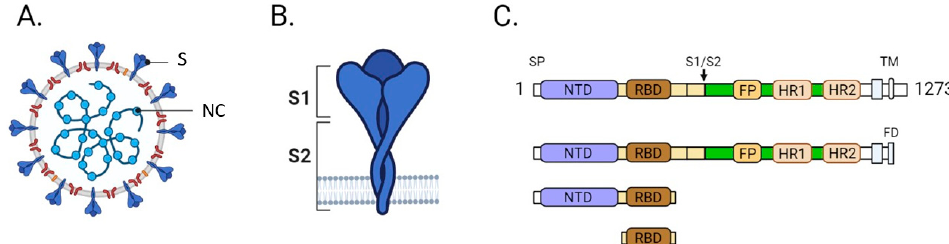
Figure 1. ( A ) Schematic drawing of the SARS-CoV-2 virus. Spike (S) and nucleocapsid (NC) proteins are highlighted. ( B ) Schematic drawing of the trimeric S-protein. ( C ) The domain structure of the S-protein is shown, and the three regions that were tested are depicted. All three versions contain the receptor binding domain (RBD). SP, signal peptide; NTD, N-terminal domain; S1, spike protein subunit 1; S2, spike protein subunit 2; FP, fusion peptide; HR1, heptad repeat 1 domain; HR2, heptad repeat 2 domain; TM, transmembrane domain; FD, foldon motif.